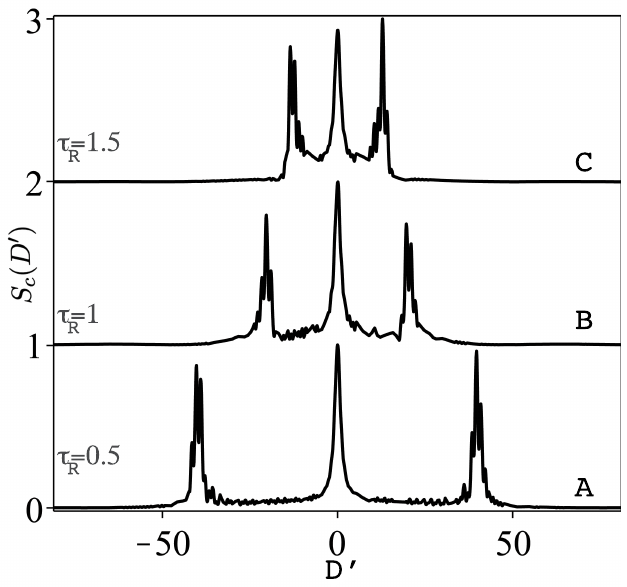
Figure 9. As Figure 5 but for the normalized spectrum S c ( D (cid:48) ) with initial coherent state, | θ = π (cid:105) , τ 1 = 0.1 π , and for weak field, curve A( Ω 1 = 0.5 ) and strong field curve B ( Ω 1 = 20).